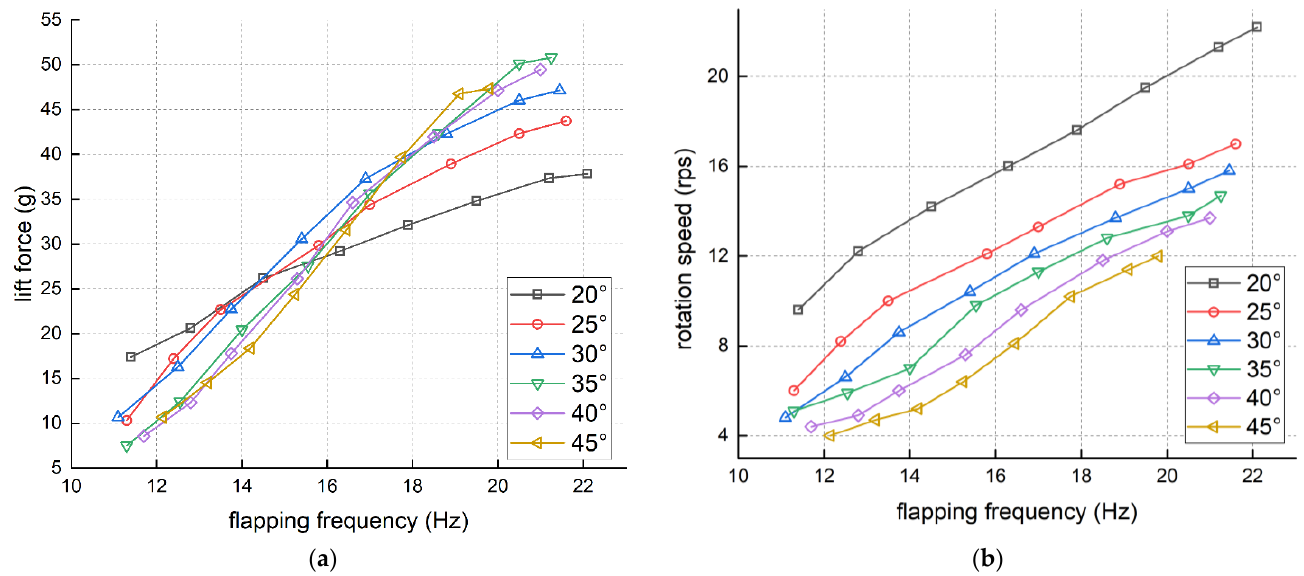
Figure 13. The influence of wing attack angle of the FWR: ( a ) The flapping frequency-lift force line chart; ( b ) the flapping frequency-rotation speed line chart.